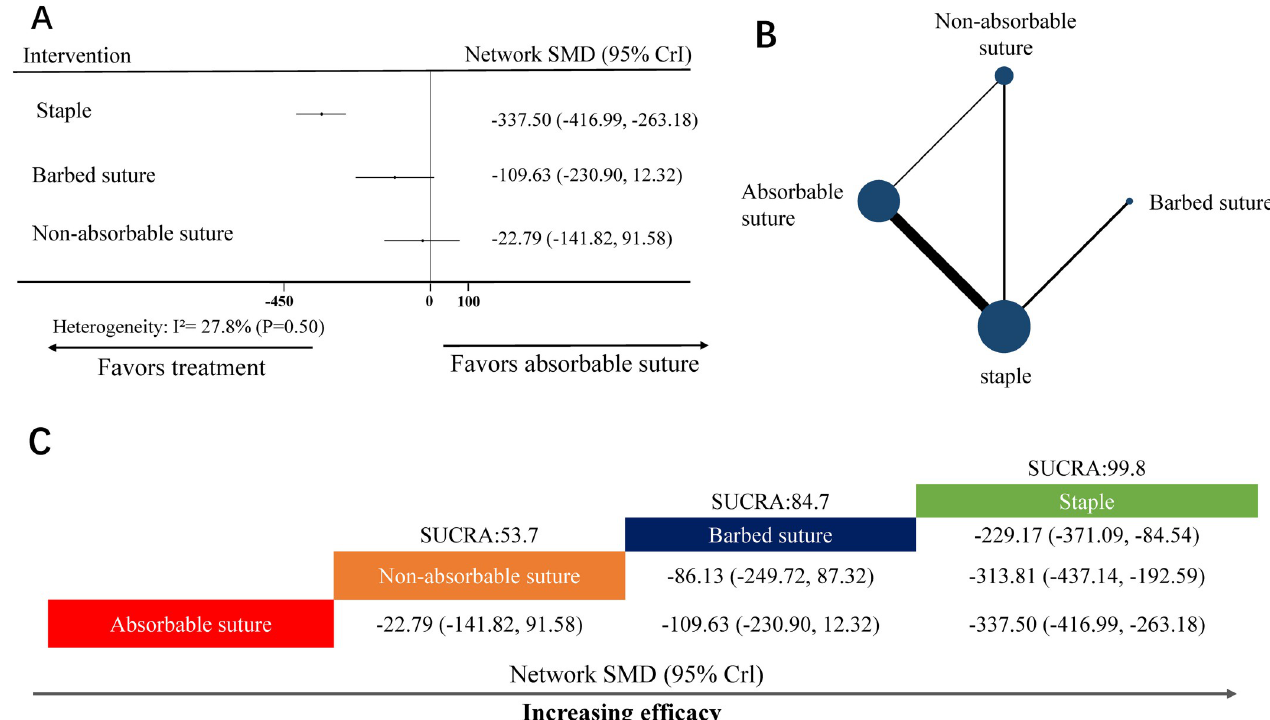
Fig 3. NMA for time to skin closure of dermal and epidermal layer (seconds). (A) Forest plot of the network meta-analysis comparing each intervention against absorbable suture. (B) Each node (blue circles) represents a unique skin closure material; moreover, the size of each node represents the included pregnant woman for the intervention. The connecting line indicates direct comparisons between both nodes. The width of each line represents the number of direct comparisons between interventions. (C) Schematic detailing the most efficacious skin closure material in NMA for time to skin closure of dermal and epidermal layer (seconds), and the surface under the cumulative ranking curve analysis (SUCRA) score. NMA, network meta-analysis; SMD, network standardized mean difference; CrI, confidence interval.